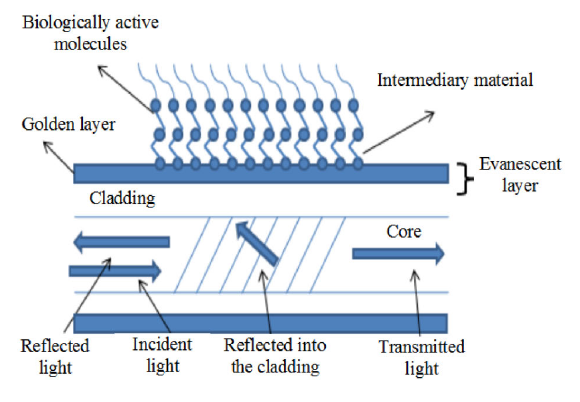
Fig. 1 Schematic diagram of TFBG-SPR protein molecular probe detection.